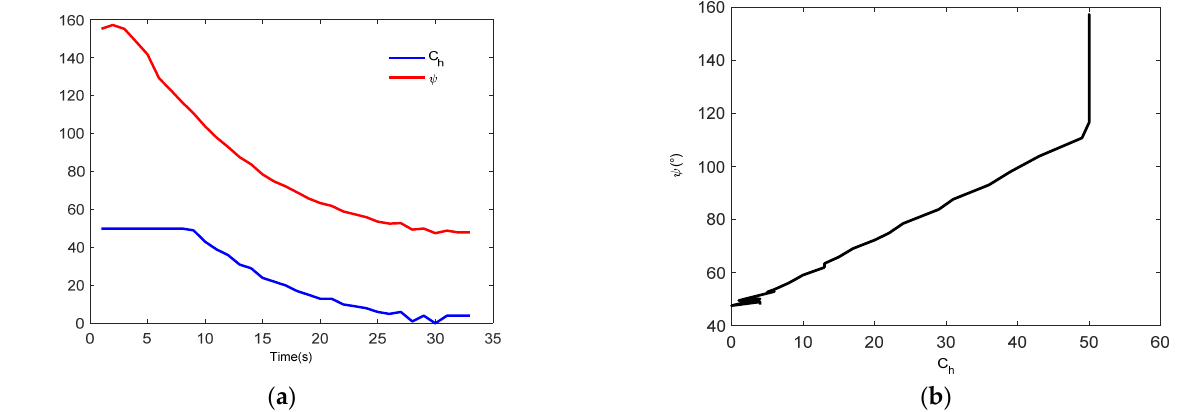
Figure 8. Course 𝜓 of the USV with control variable C u = 70 and differential control variable C h (0~50) (lake data in 2017). ( a ) Course and differential control variable; ( b ) course with control variable.